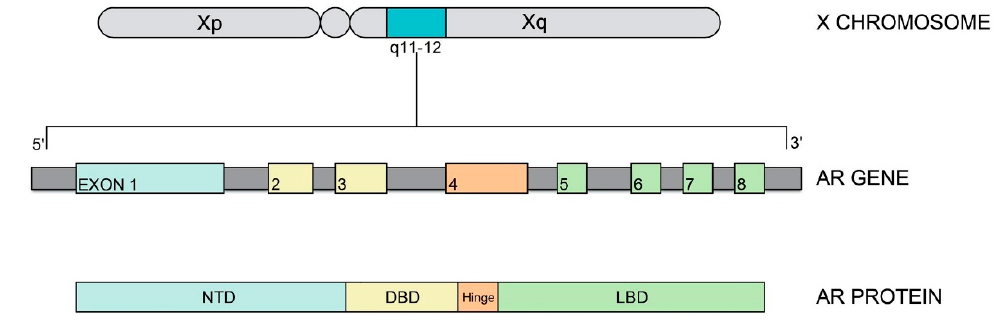
Figure 1. Androgen receptor gene and protein.